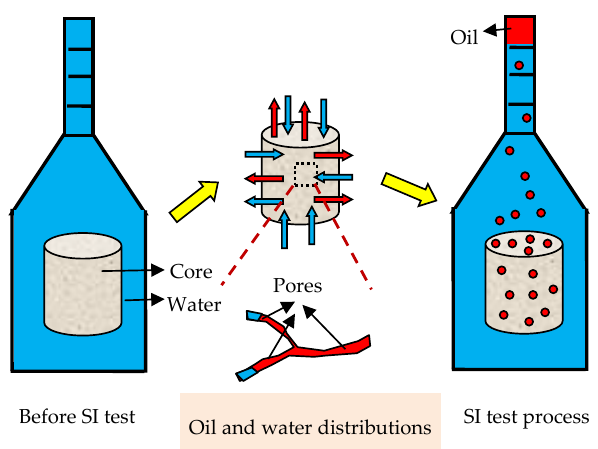
Figure 1. The sketch of oil and water distribution in SI process.